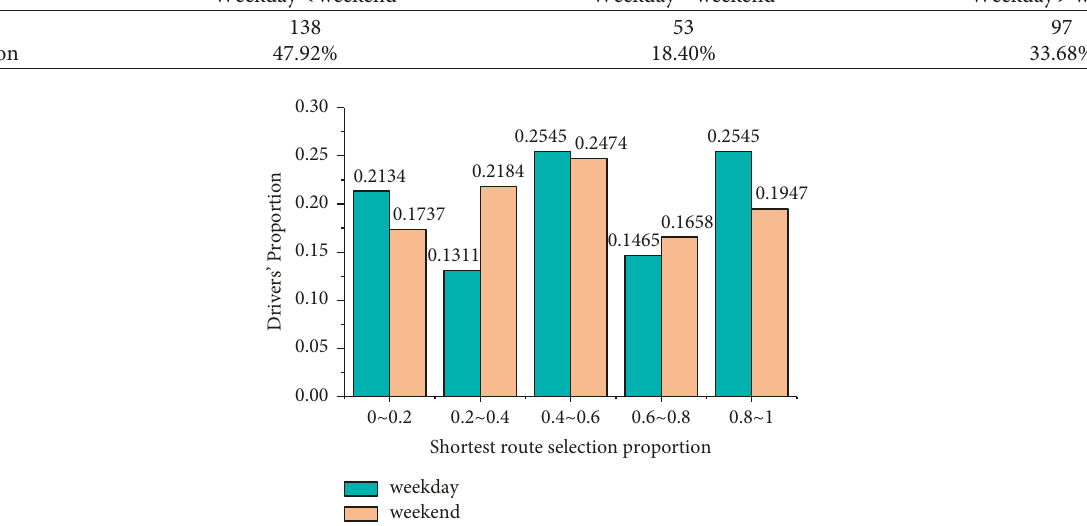
Figure 11: Interval distribution of the shortest path selection for the overall drivers.